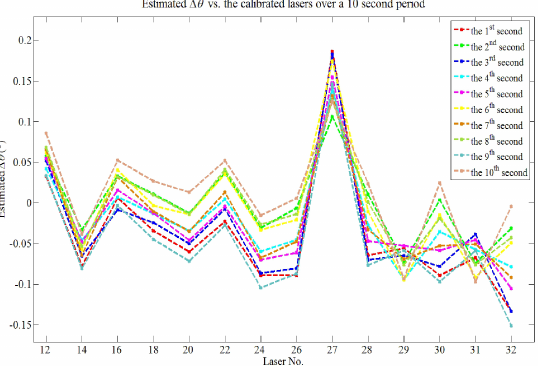
Figure 12. The standard deviations of the estimated Δ ρ by the calibration for Dataset 2 over a 10 second period